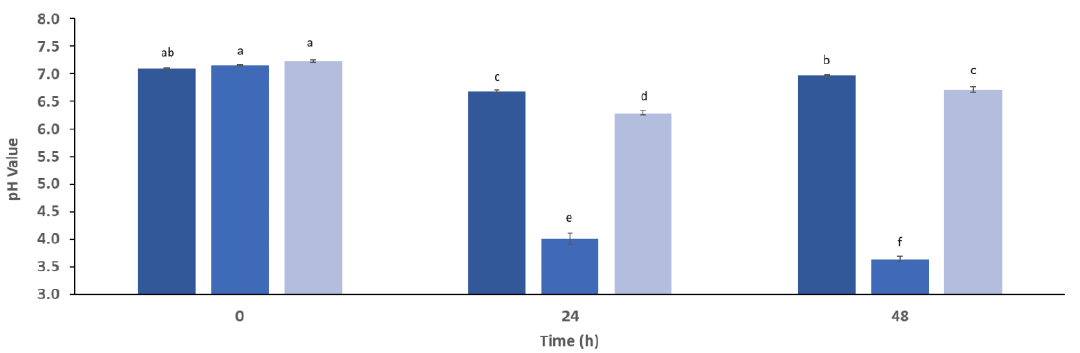
Figure 3. The changes in pH value of simulated gut microbiota fermentation (five donors) along 48 h in the presence of inoculum control that represents media with only fecal inoculum (IC, ■ ), fructooligosaccharides (FOS, ■ ), and straw extract after fermentation with S. cerevisiae ( ■ ). a,b,c,d,e,f Different letters mean significant differences ( p < 0.05) between samples.